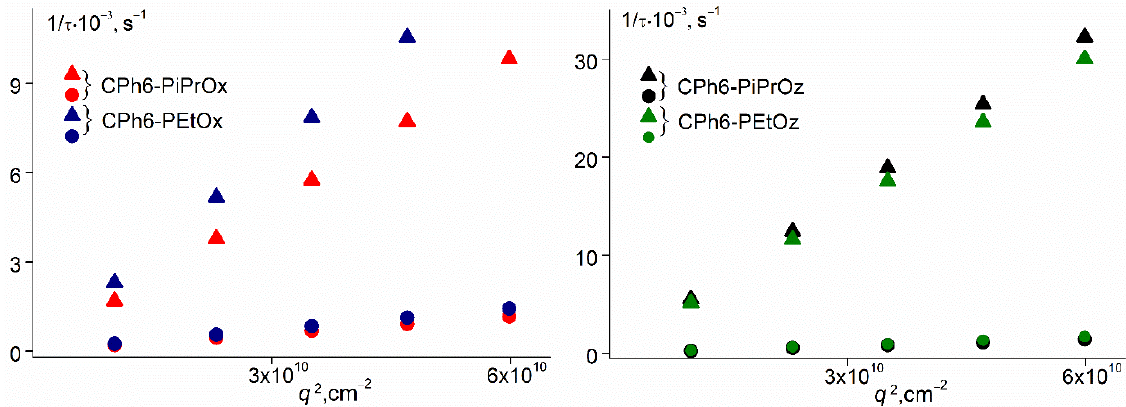
Figure 2. Relaxation time 1/ τ on squared wave vector q 2 for CPh6-PAlOz and CPh6-PAlOx at 21 ◦ C. The polymer concentrations varied from 0.0002 to 0.015 g cm − 3 for CPh6-PiPrOx and CPh6-PiPrOz and from 0.005 to 0.025 g · cm − 3 for CPh6-PEtOx and CPh6-PEtOz. The solutions were filtered into dust-free vials using Millipore filters with hydrophilic PTFE membrane and pore size of 0.45 µ m (Merck KGaA, Darmstadt, Germany). Microcalorimetric studies of aqueous solutions of star-shaped CPh6-PAlOz and CPh6- PAlOx were carried out on a MicroCal PEAQ-DSC microcalorimeter (Malvern Instruments Limited, Worcestershire, UK) with a capillary cell with a volume of 0.507 mL at a heating rate of 1 ◦ C/min and a pressure of 50 kPa. The temperature range of measurements was chosen depending on the characteristics of the polymer (from 5 to 60 ◦ C for CPh6-PiPrOz and from 15 to 100 ◦ C for CPh6-PiPrOx, CPh6-PEtOx, and CPh6-PEtOz). The solution concentrations varied from 0.001 to 0.015 g cm − 3 for CPh6-PiPrOx and CPh6-PiPrOz, and from 0.005 to 0.025 g cm − 3 for CPh6-PEtOx and CPh6-PEtOz. The phase transition heat ∆ H was calculated using the OriginLab taking into account the polymer